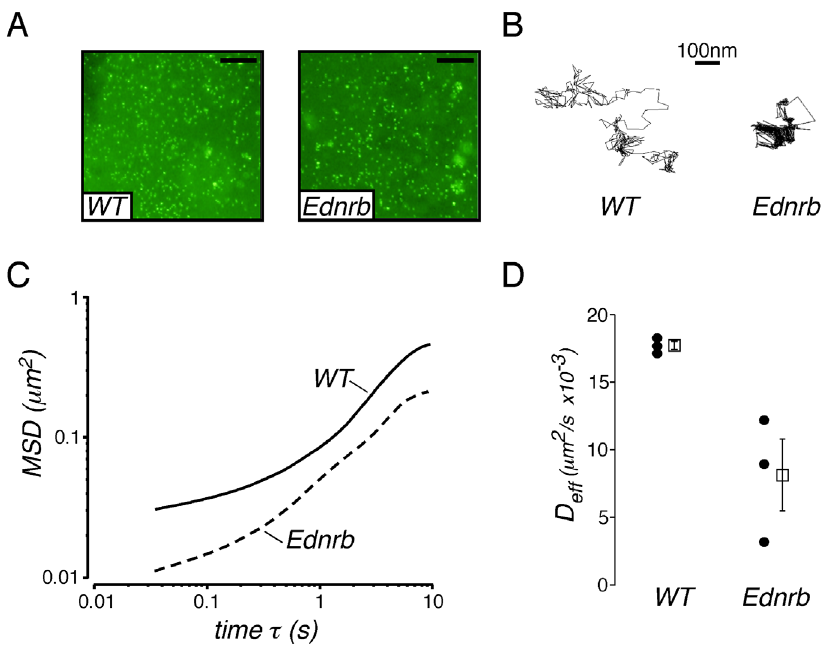
Figure 5. Transport of microspheres in mucus on explanted Ednrb 2 / 2 and WT mouse colon. A. Images from WT and Ednrb 2 / 2 surface mucus showing equilibration of 200 nm fluorescent particles throughout the mucus layer. B. Representative 20-second trajectories of particles in WT and Ednrb 2 / 2 mucus. C. Ensemble averaged mean-squared displacement (MSD) for carboxylate-modified particles in WT and Ednrb 2 / 2 mucus as a function of time. D. Ensemble effective diffusion coefficients of particles at a time scale of 10 seconds in WT and Ednrb 2 / 2 mice. Black dots represent individual experimental averaged runs, and open squares represent the mean 6 SEM. Scale bar=20 m m (A).